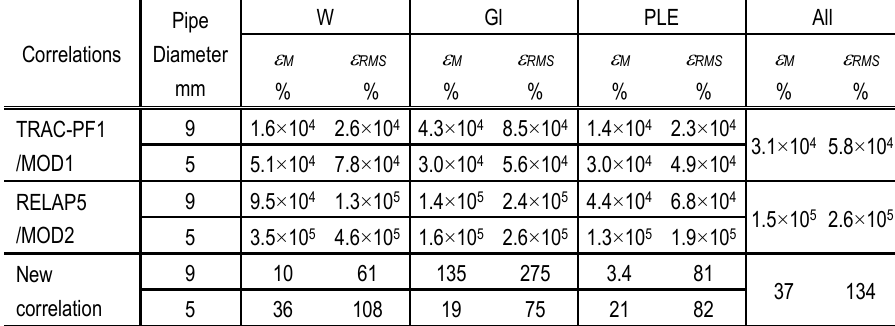
Table 3 Mean and RMS errors in drag coefficient prediction by 3 correlations for large bubble in slug